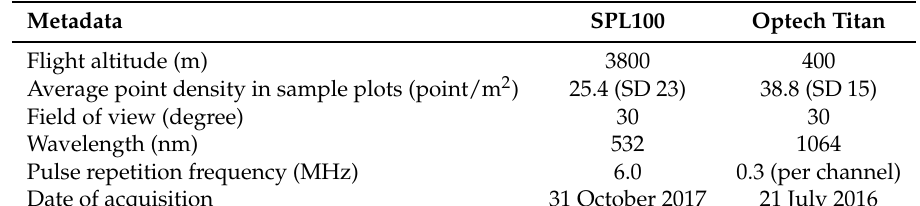
Table 1. Metadata of the two acquisitions of ALS data.